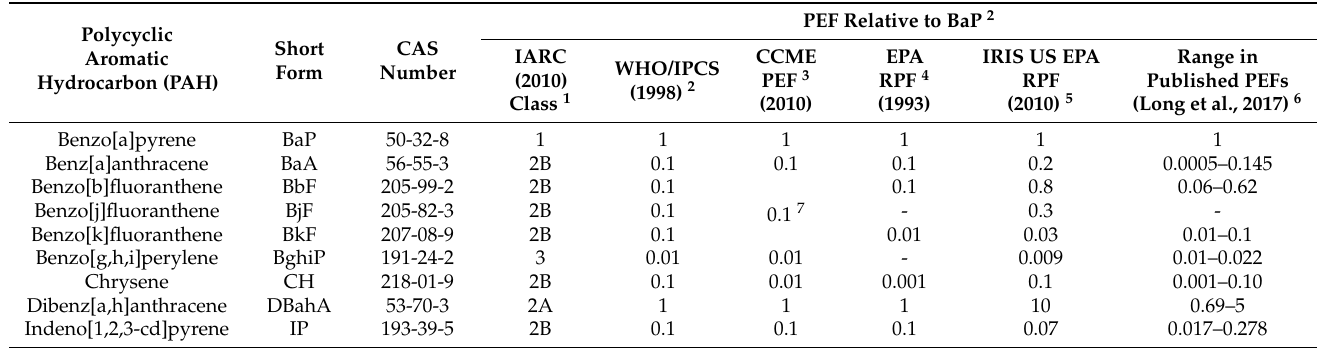
Table 1. Survey of Potency Factors for the Most Commonly Examined Polycyclic Aromatic Hydrocar- bon